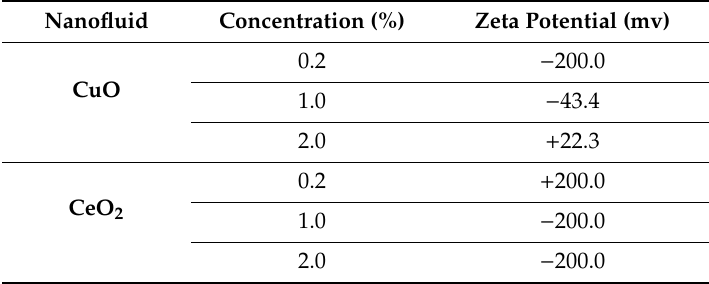
Table 1. Variation of Zeta potential with